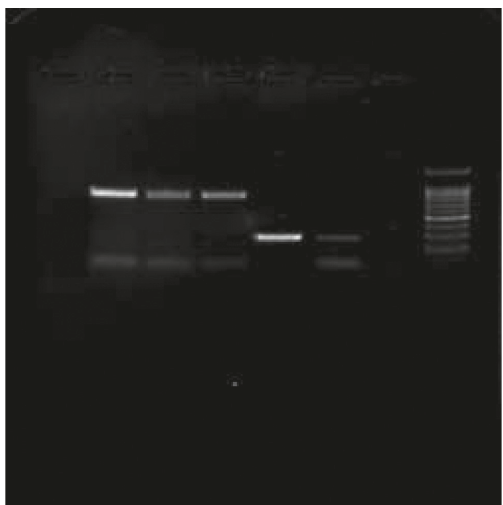
Figure 5: PCR product electrophoresis of 275bp algD gene (lanes 1–3: positive samples, lane 4: positive control, lane 5: negative control, and lane 6: marker 100bp).